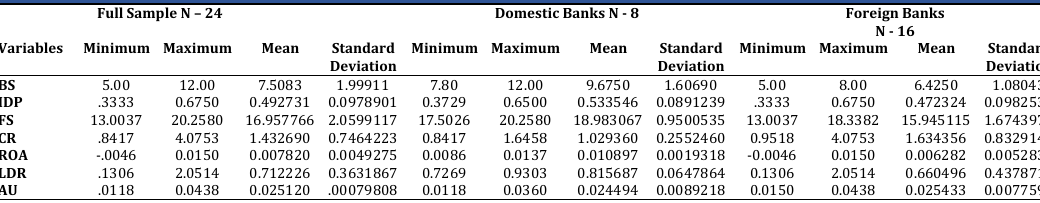
Table 4: Descriptive statistics of overall period (2012-2016): Domestic banks and Foreign